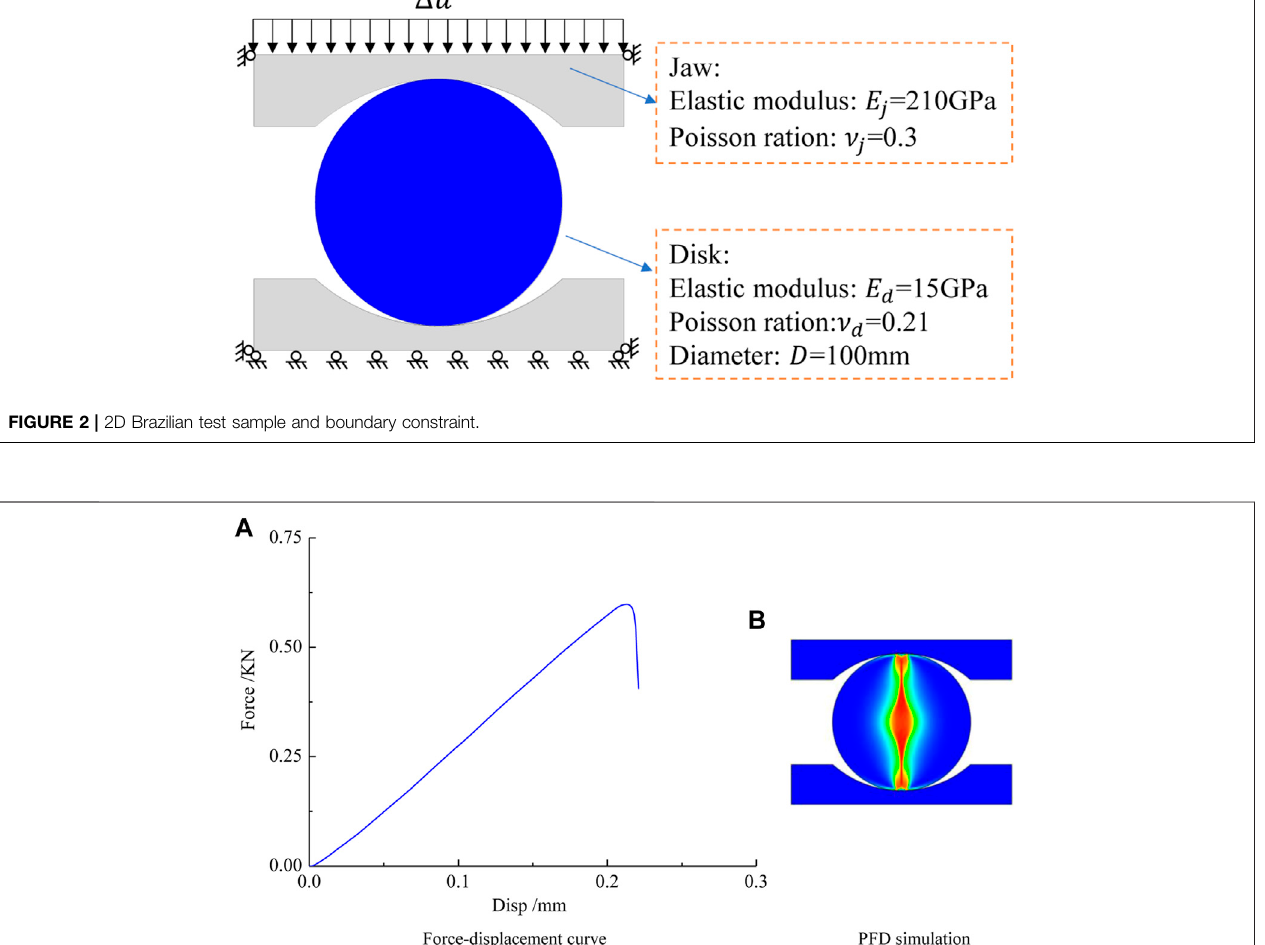
Frontiers in Physics |